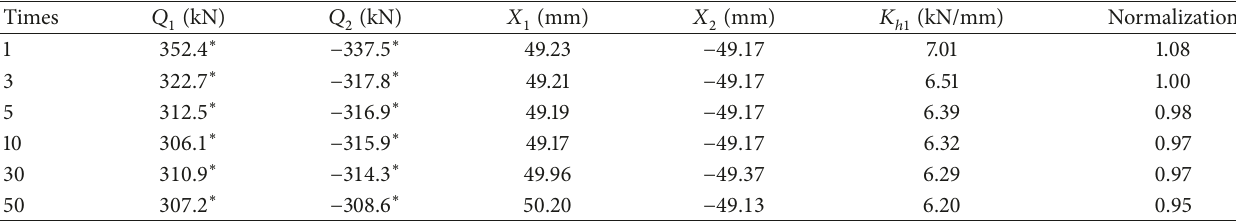
Table 6: Test results of 𝐾 ℎ1 in different loading times.